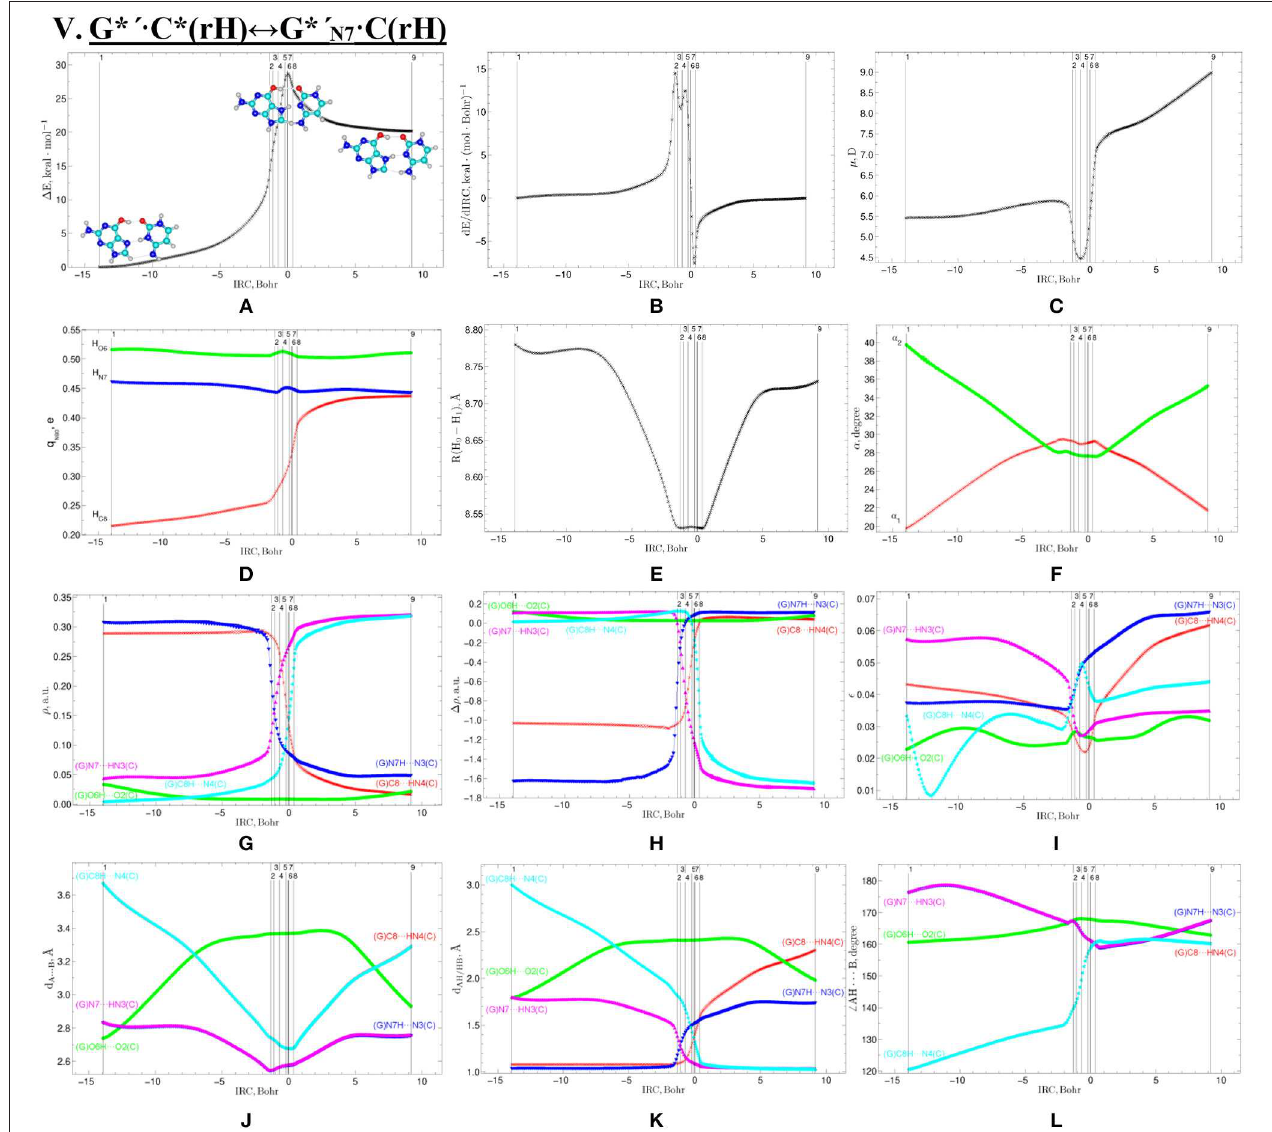
C(rH) tautomerisation via the DPT obtained at the C*(rH) G* ′ N7 · · ↔